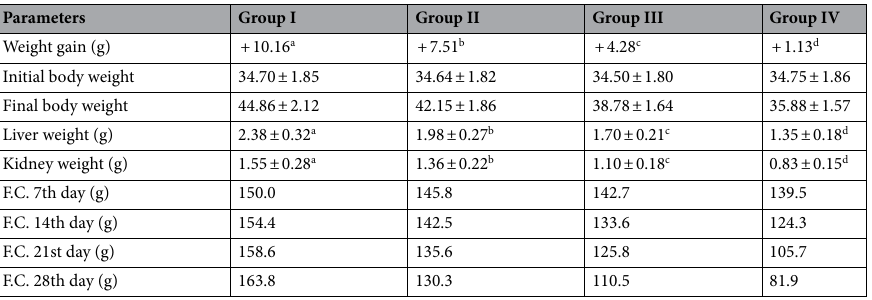
Table 1. Effects of Paraquat on feed consumption, body and organ weights. Group I: Control, Group II: 50 mg/kg b.w Paraquat, Group III: 100 mg/kg b.w Paraquat, Group IV: 200 mg/kg b.w Paraquat. F.C Feed consumption over the previous 7 days. Values are shown as mean ± SD (n = 6). Means shown with different letters on the same line are significantly different (p <